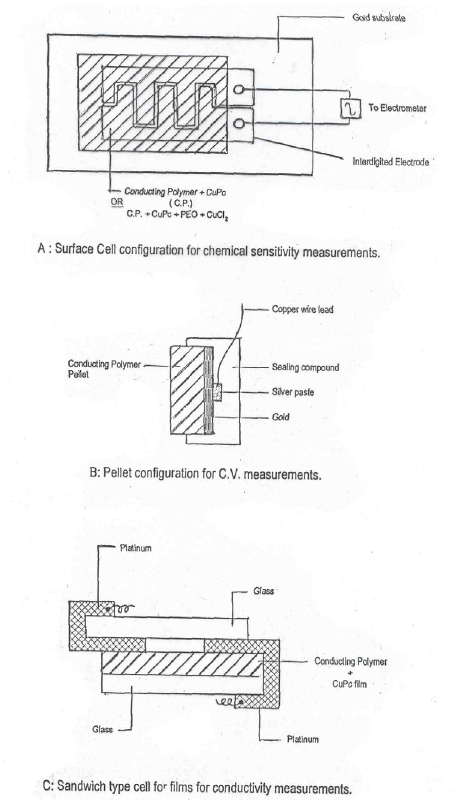
Figure 1. Schematic diagram of inter-digited surface cell used for Sensitivity